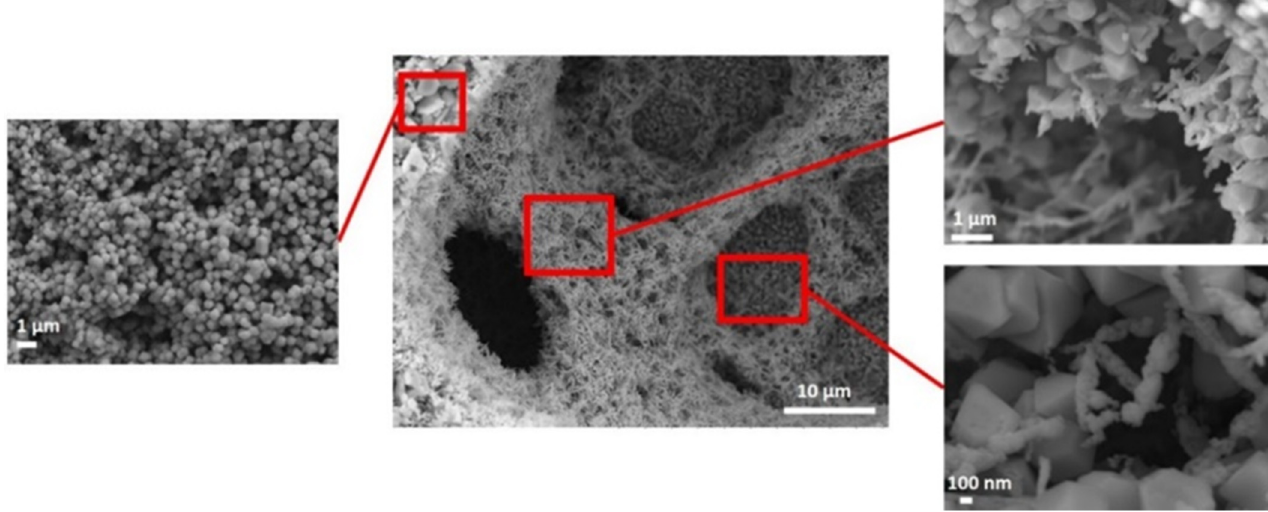
Figure 3. Morphology study of CF-18H-100U, displaying the different structures at the top, middle and bottom of the pore.